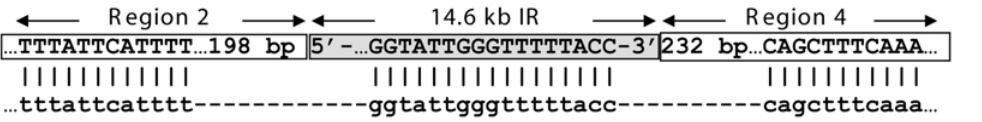
Table 1. Levels of polymorphism at two loci near the 2Rj breakpoint junction from standard and inverted